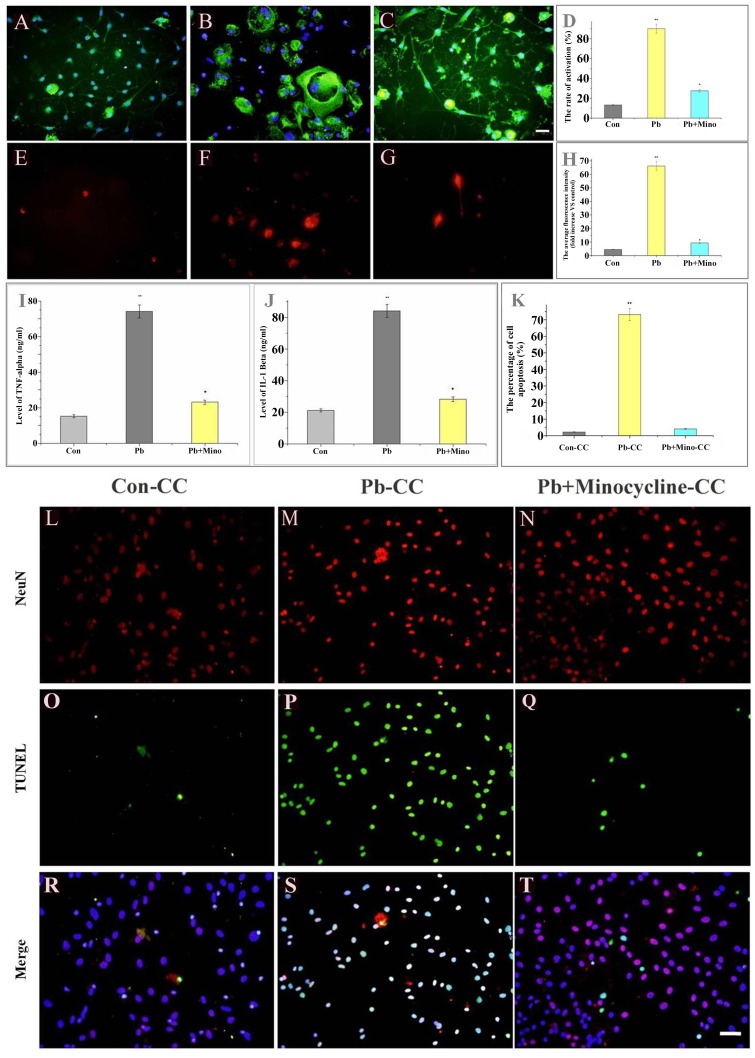
Minocycline blocks the activation of microglia; attenuates Pb-induced secrete of TNF-α, IL-1β and expression of iNOS; and protects co-cultured hippocampal neurons.Purified microglia were treated with vehicle (control) (A), Pb (50 µmol) (B), or Pb (50 µmol)+minocycline (45 µmol) (C) for 48 h, and were co-cultured with hippocampal neurons for another 48 h. (A, B, C) Microglia activation was detected by OX-42 antibody. (D) The results were quantified. Results (A, B and C) are expressed as the mean ± S.D. of average activated cell rate in random fields (n = 20). **P<0.001 compared with control groups. *P<0.01 compared with Pb-treated groups. iNOS was detected by anti-iNOS antibody (E, F, G. red fluorescence). Activation of iNOS was evaluated by measure the average fluorescence of iNOS-immunoreactive cells. (H) The results were quantified. Results (E, F and G) are expressed as the mean ± S.D. of average fluorescence of iNOS-immunoreactive cell number in random fields (n = 20). **P<0.001 compared with control groups. *P<0.01 compared with Pb-treated groups. TNF-α (I) and IL-1β (J) were determined by ELISA. Purified microglia were treated with vehicle (control) or Pb (50 µmol), or Pb (50 µmol)+minocycline (45 µmol) for 48 h for the TNF-α and IL-1β assay, respectively. **P<0.001 compared with control groups. *P<0.01 compared with Pb-treated groups. Apoptotic hippocampal neurons were detected and compared using TUNEL (green fluorescence) (L–T). Degeneration of hippocampal neurons was evaluated by counting the number of apoptotic neurons. (K) The results were quantified and are expressed as the mean ± S.D. of apoptotic neurons percentage in random fields (n = 20). **P<0.001 compared with control groups. *P<0.01 compared with Pb-treated groups. All scale bar indicates 50 µm.